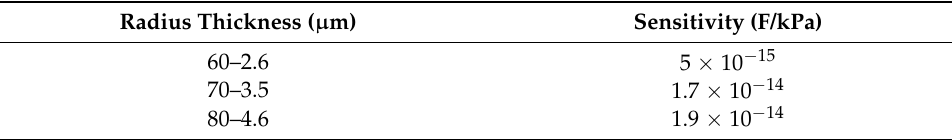
Table 3. The sensitivity of different membrane radius thickness combinations.